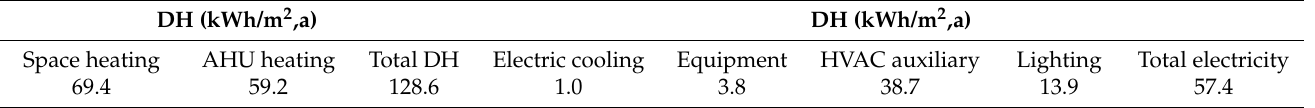
Table 3. Energy consumption for the reference case.